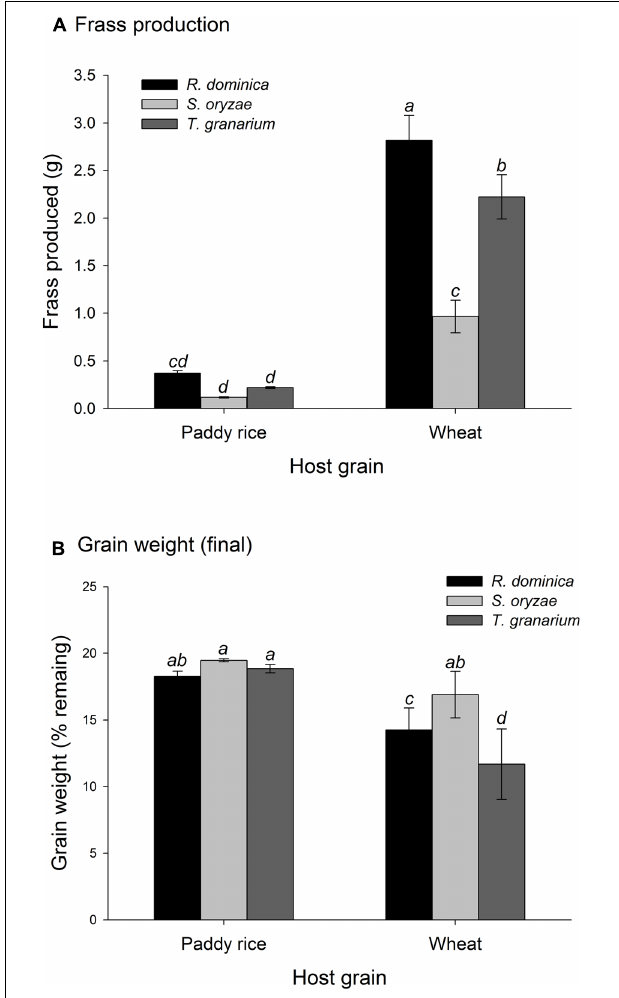
FIGURE 3 | Frass production (A) and final grain weight (%) (B) by insect populations from single-species experiment in grains of two cereal host species, paddy rice and wheat. The histogram bars refer the average of nine replicates and the vertical bars represent are standard errors of the mean. Histogram bars with the same letter are not significantly different by Tukey’s HSD test ( P <